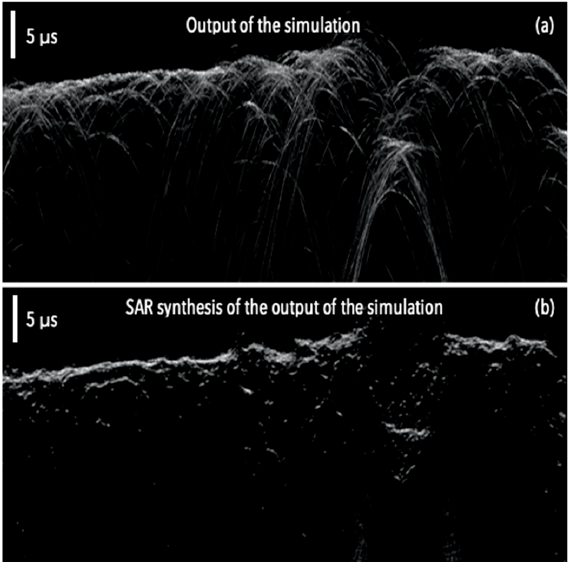
Figure 2. ( a ) Output of the simulation of a 150 km portion of the SHARAD dataset n°5128501 in Terra Cimmeria using a MOLA DTM. ( b ) Same profile after SAR synthesis. Parabolas in the simu- lation are the result of the trajectory of the spacecraft relative to each reflector.